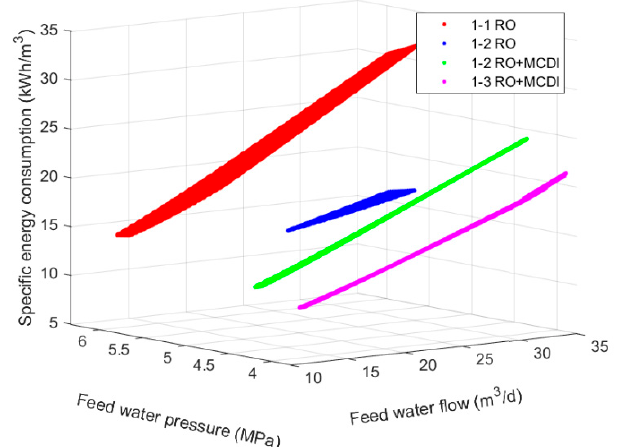
Figure 5. Relationship among feed water pressure, feed water flow and system-specific water energy consumption of RO under constraint condition of water production.